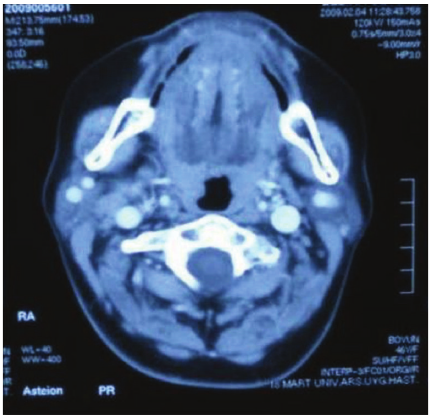
Figure 2: Bilateral absence of submandibular gland in the first case.